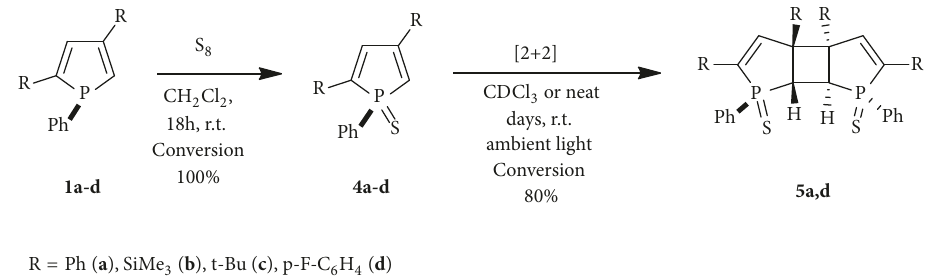
Scheme 3: Phosphole oxidation with S 8 then [2+2] dimerization.